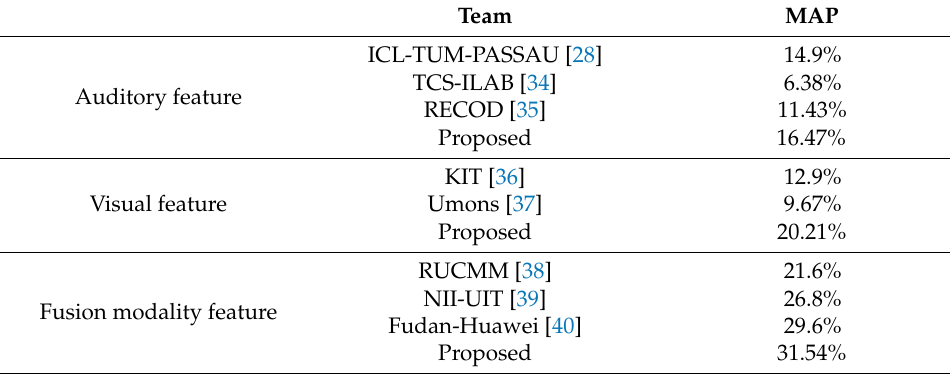
Table 6. Comparison of recognition results of violent